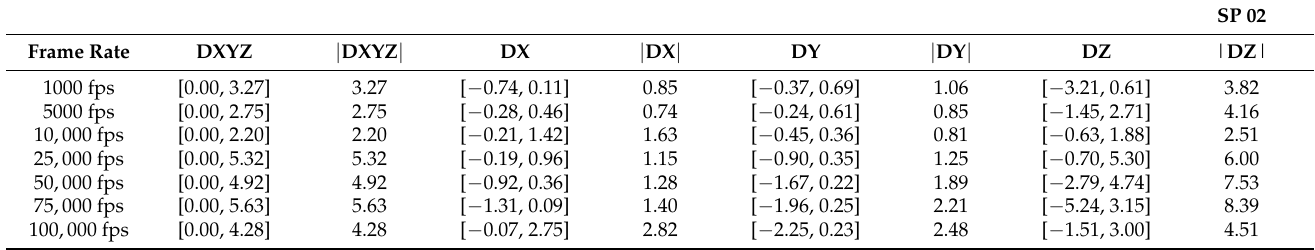
Table 5. Range variation of apparent displacements DXYZ , DX , DY , and DZ for SP 02, in [ µ m].